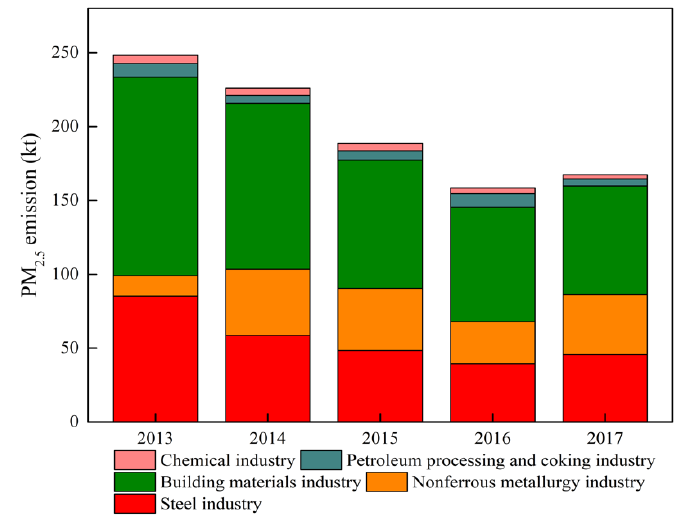
Figure 12. Trends in PM 2.5 emission from major industrial processes.